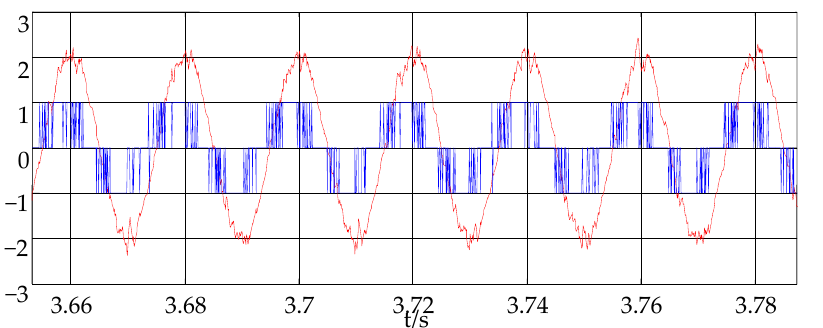
Figure 12. a-phase stator current (reduced) waveform and corresponding pulse waveform.